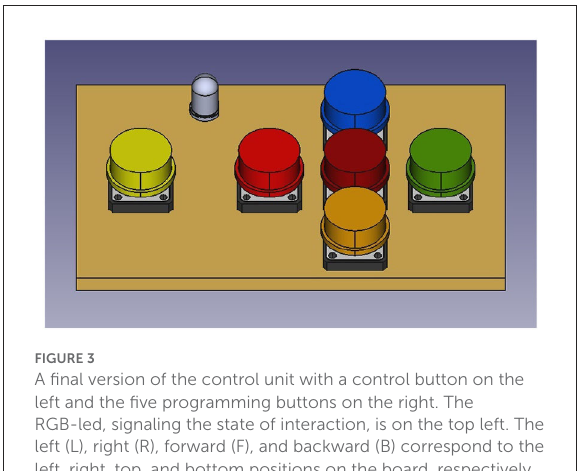
FIGURE3 A final version of the control unit with a control button on the left and the five programming buttons on the right. The RGB-led, signaling the state of interaction, is on the top left. The left (L), right (R), forward (F), and backward (B) correspond to the left, right, top, and bottom positions on the board, respectively. In the middle, the stop or halt button (H).